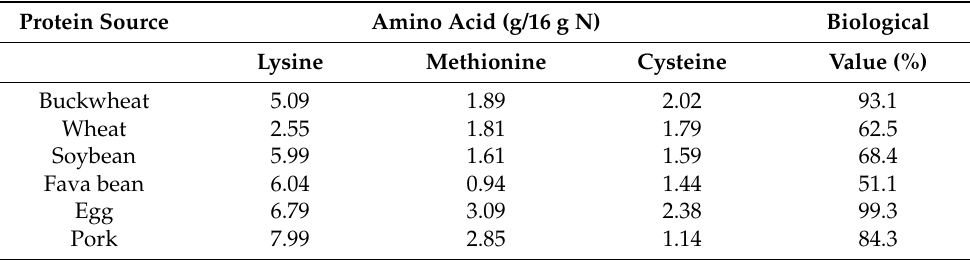
Table 1. Contents of essential amino acids and biological value of various protein sources (adapted from Eggum